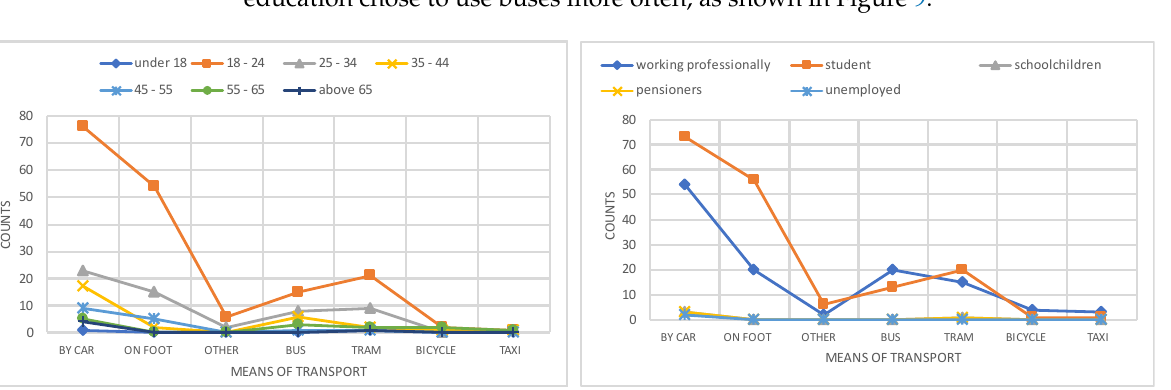
Figure 9. The choice of individual means of transport by users in the direction of Home – cemetery.